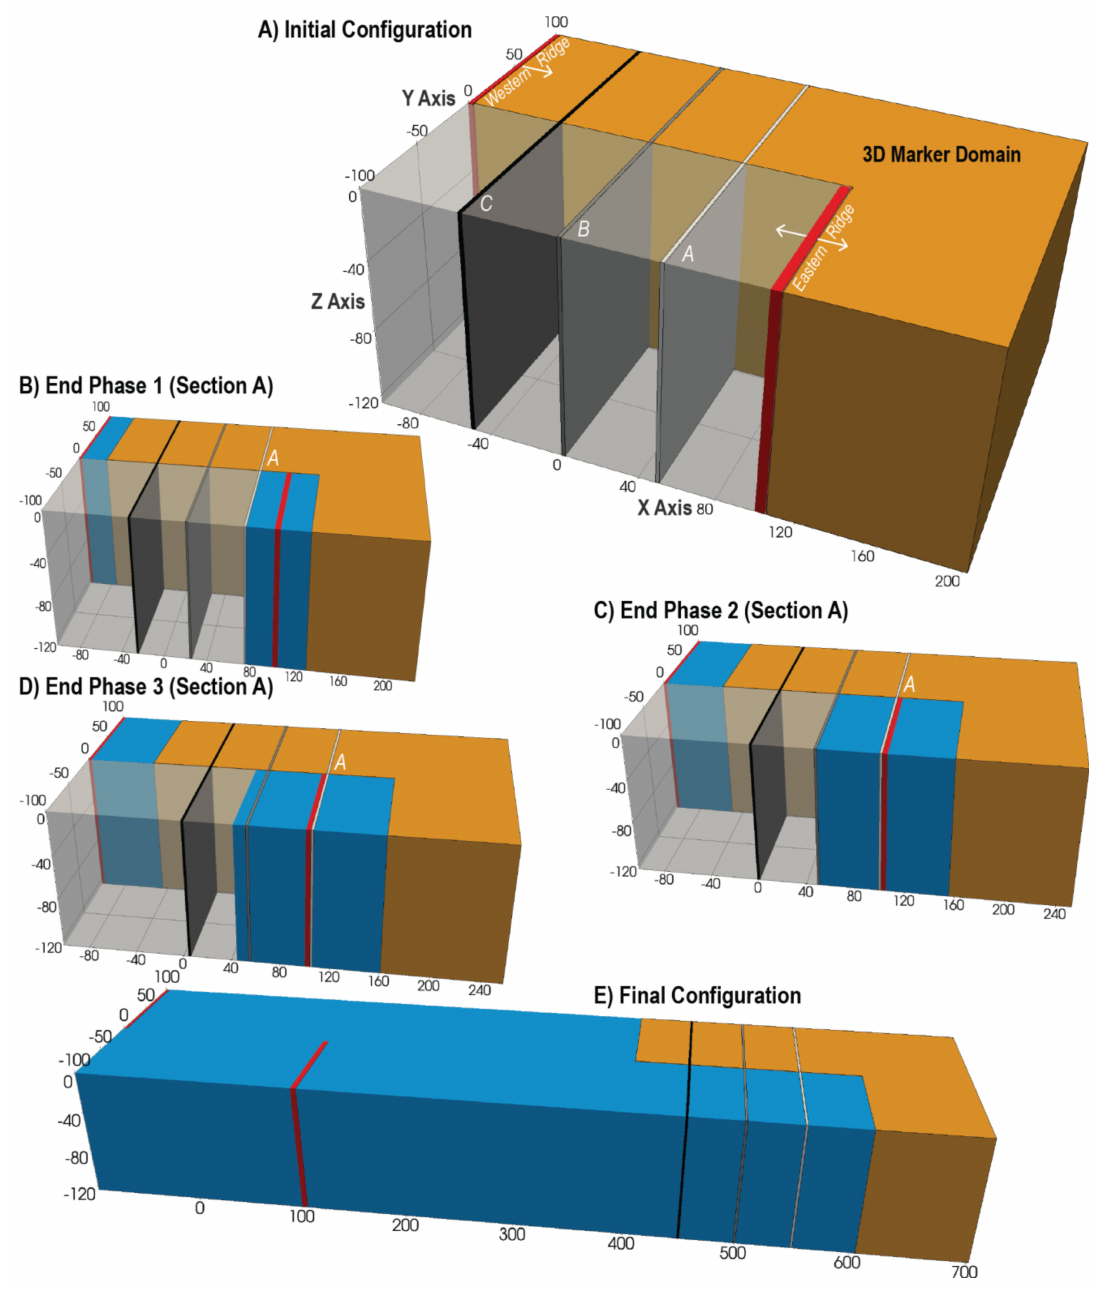
Figure 1. Model geometry through various stages along the transform margin. ( A ) Initial configuration: Two 5 km wide ridges are formed (red boxes) and spread symmetrically around their axes (white arrows). The orange 3D marker block is used to track the evolution of the continental lithosphere. Note that only the westernmost L-shaped marker domain of the eastern continental lithosphere is displayed here; the total model extent is 1000 km. The transparent grey box represents the initial continental lithosphere complementing the orange marker block. The marker planes, A, B, and C, are located 50, 100, and 150 km away from the left edge of the eastern ridge and extend along the entire N-S axis. The marker sections are frozen w.r.t. the 3D marker block, i.e., the entire section moves east with the spreading velocity. ( B ) Position of the marker sections and the 3D marker domain at the end of continent-continent transform at Section A. Blue regions denote oceanic lithosphere. ( C ) Configuration at the end of the ocean-continent transform phase at Section A. ( D ) Configuration at the end of the ridge pass phase at Section A. ( E ) Final configuration at the end of the simulation, far into the passive margin phase of sections A to